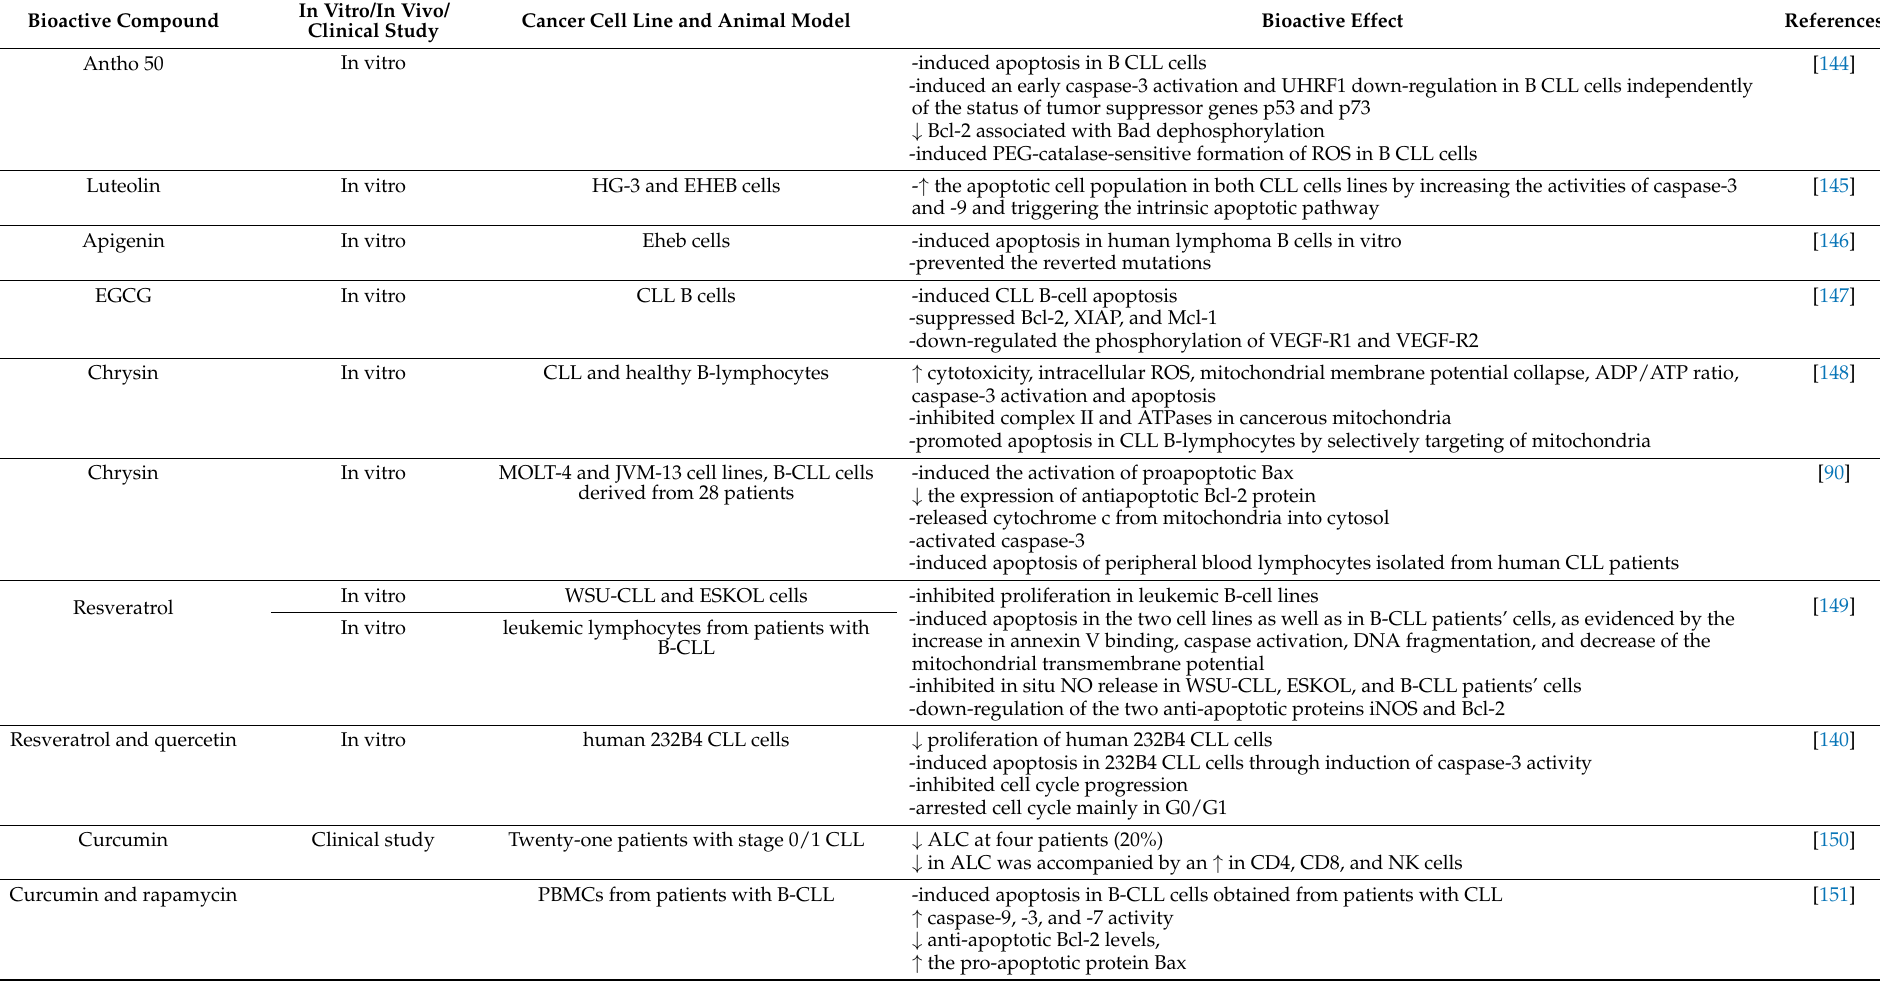
Table 4. Pharmacological effects of natural compounds in chronic lymphocytic leukemia